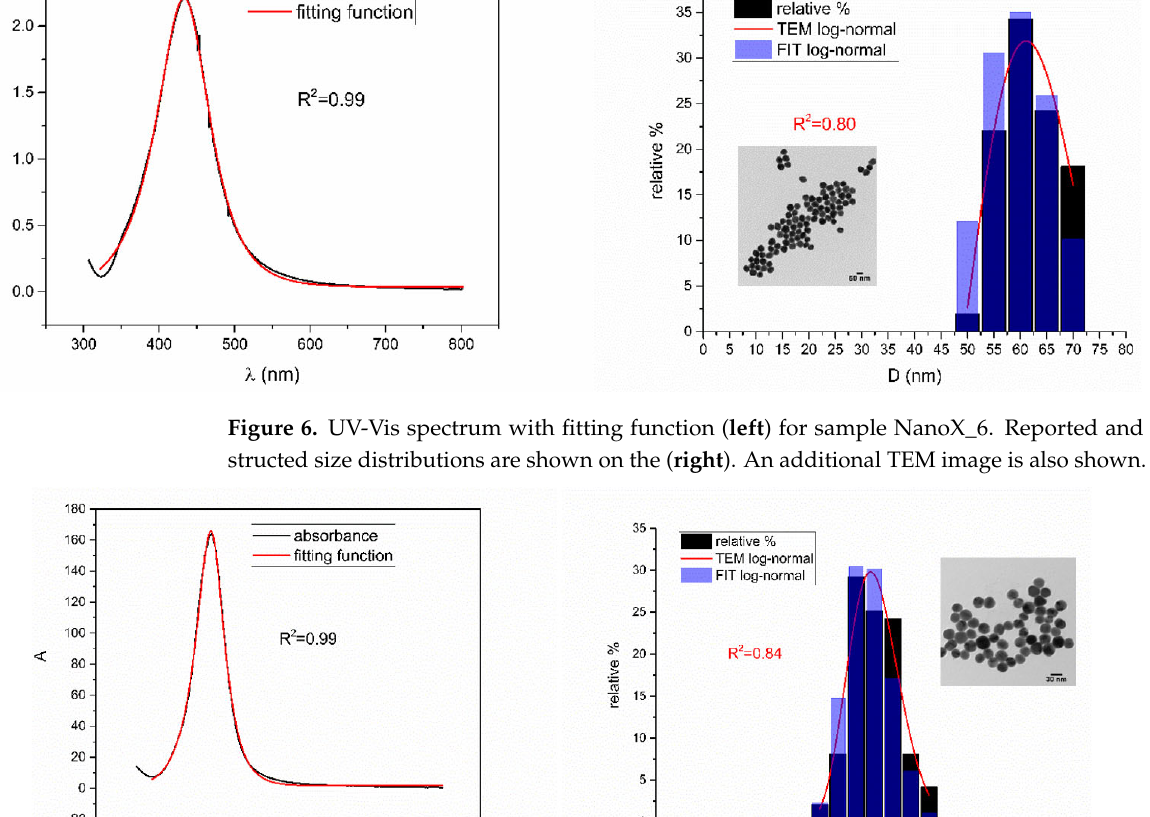
Figure 5. UV ‐ Vis spectrum with fitting function ( left ) for sample Ag_5. Reported and reconstructed size distributions are shown on the ( right) . An additional TEM image is also shown.